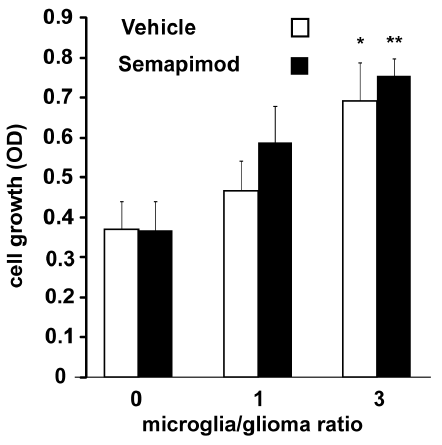
Figure 3. Semapimod does not affect microglia-stimulated growth of glioblastoma cells invitro . GL261 cells were cultured in the presence or absence of microglia at the indicated ratio’s, in the presence and absence of 200 nM semapimod. Cell growth over a period of 3 days was determined using the SRB method. Data shown represent the average + / 2 SEM of 3 independent experiments. *: p , 0.05, **: p , 0.01 student’s 2 tailed t-test.